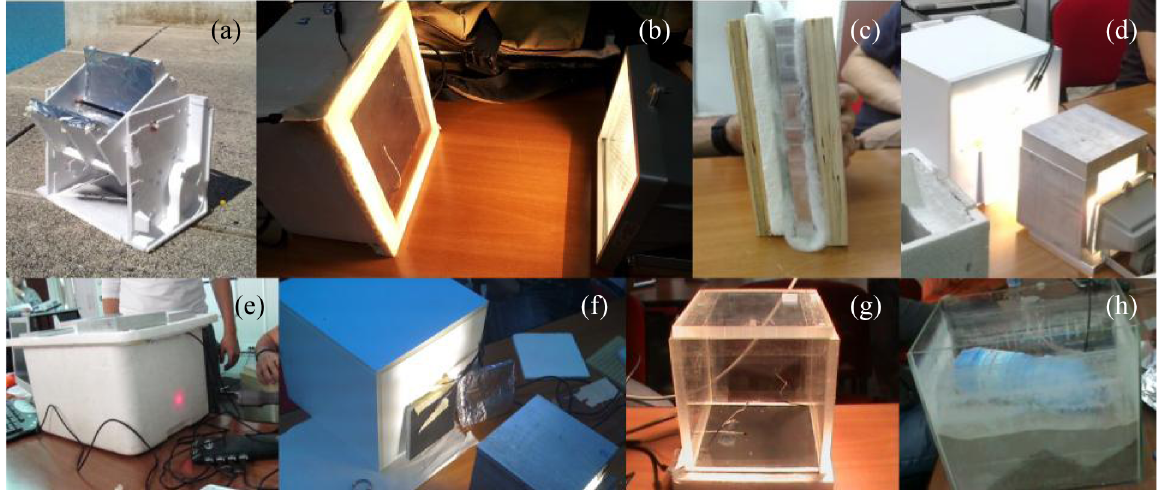
FIG. 1 (color online). PicturesofspecificdevicesassembledbythestudentsduringtheOIexperience:aparabolicmirror(a),ascalemodel of Trombe-Michel wall (b), insulating systems (c) – (f), the greenhouse effect (g), a modeled underground hypothetical Martian base